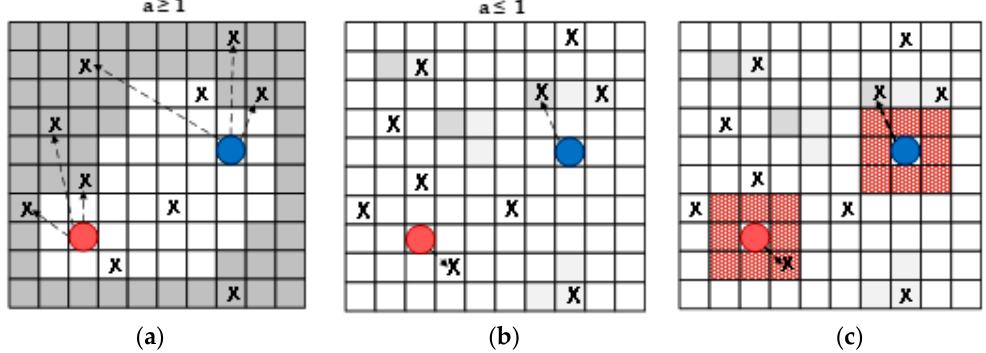
Figure 1. The proposed Multi-Objective Grey Wolf Optimizer (MOGWO) exploration in two stages: ( a ) selecting the waypoints in unexplored space with high probability values of occupancy grid map; ( b ) selecting the closest waypoints in explored space with high probability values proportional to the distance; ( c ) the next position is one of the frontier points, which is the nearest to the selected waypoint.